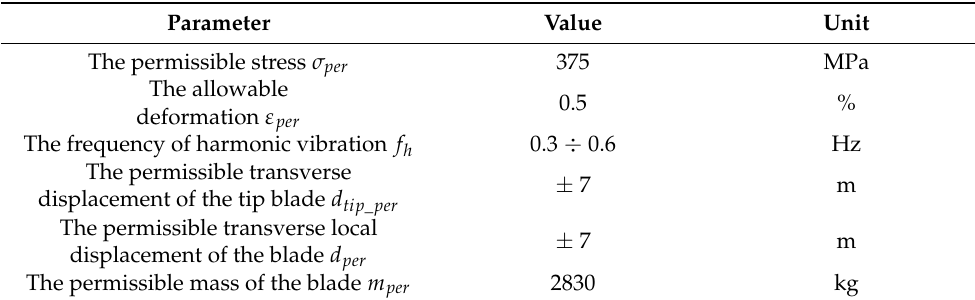
Table 4. The assumed in the proprietary program are the constraint conditions.